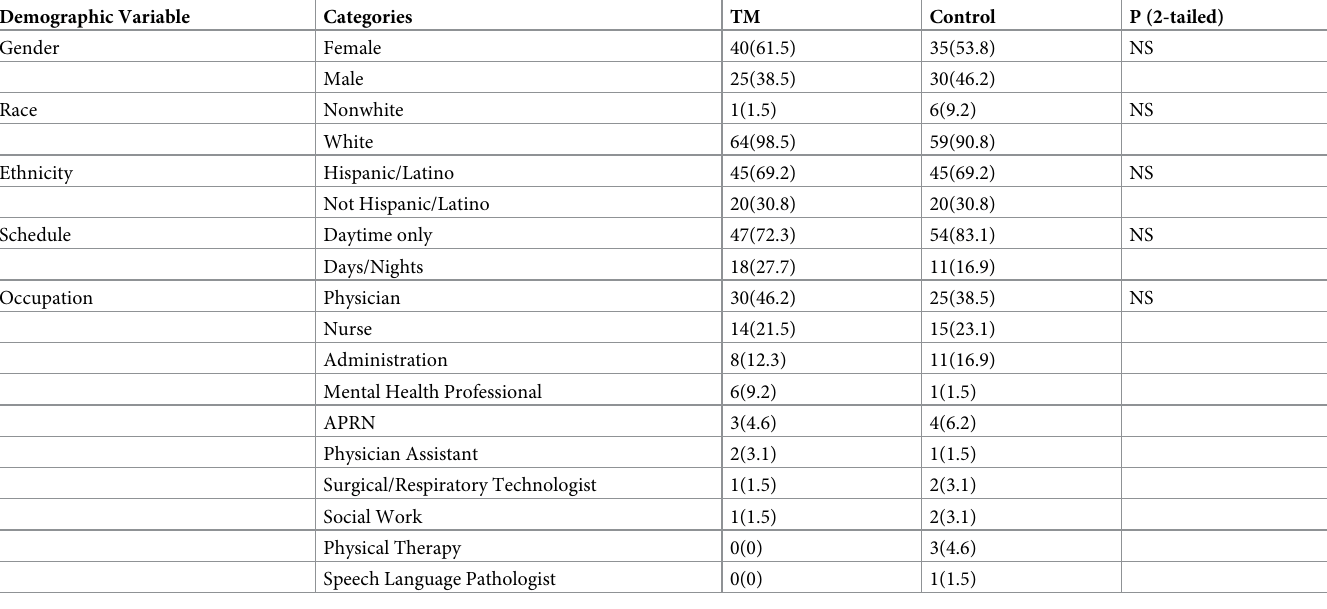
Table 1. Comparison of groups at baseline on demographic